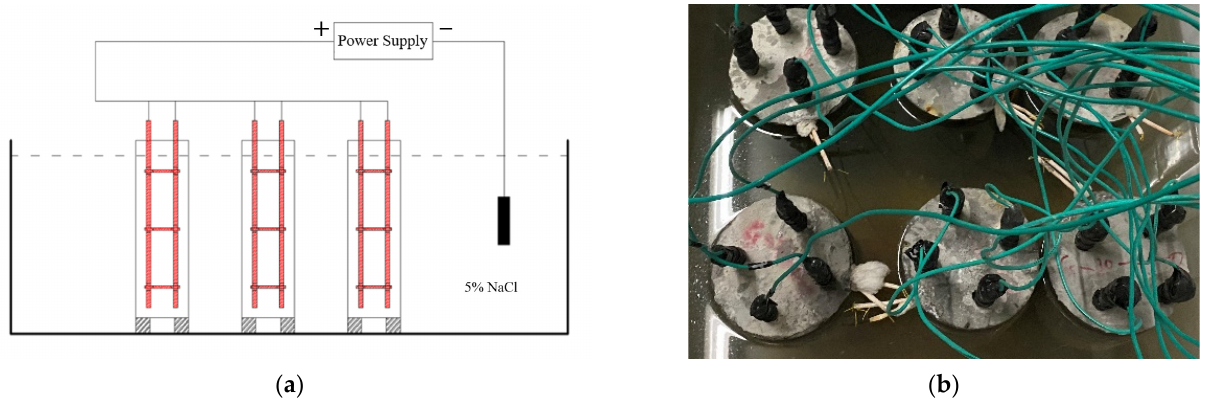
Figure 4. Accelerated corrosion device: ( a ) Reinforcement arrangement, ( b ) specimens in electro- chemical corrosion.